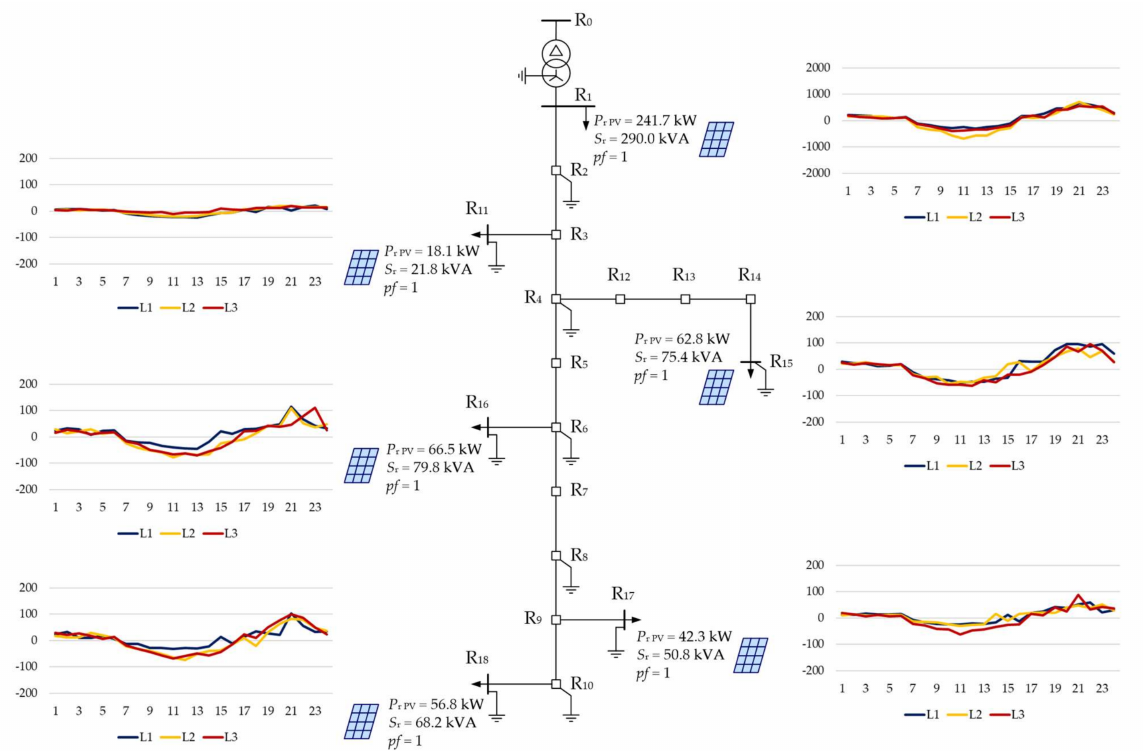
Figure A12. Daily simulation results for variant V9: phase currents